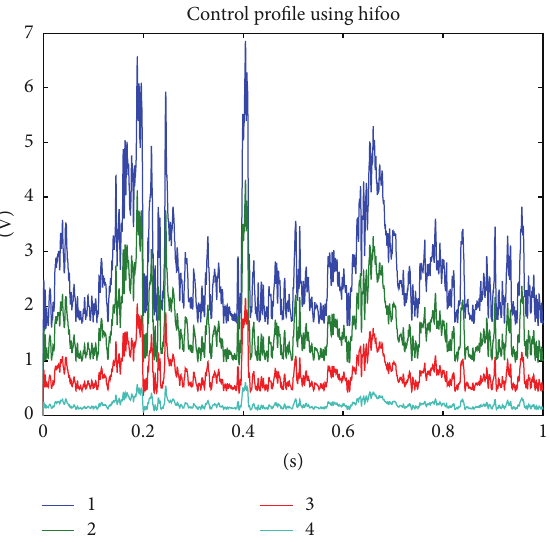
Figure 19: Stress at beam nodal points, using